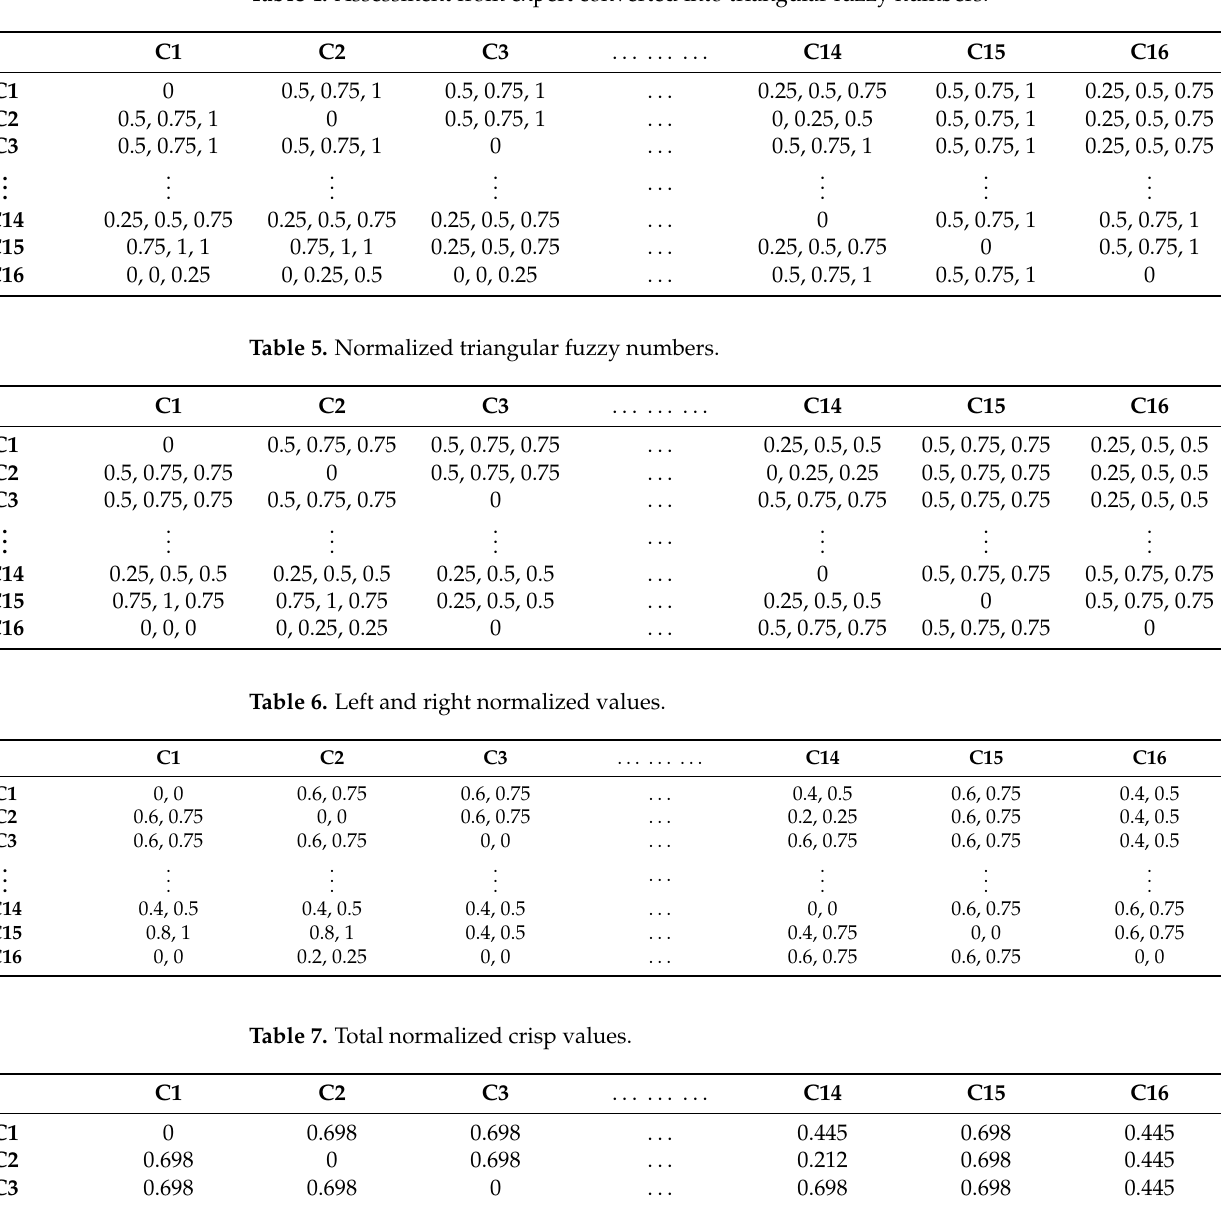
Table 4. Assessment from expert converted into triangular fuzzy numbers.